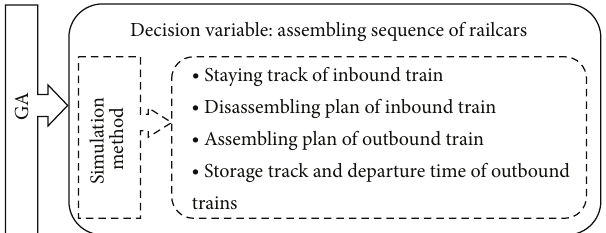
Figure 3: The solution framework of operating plan.